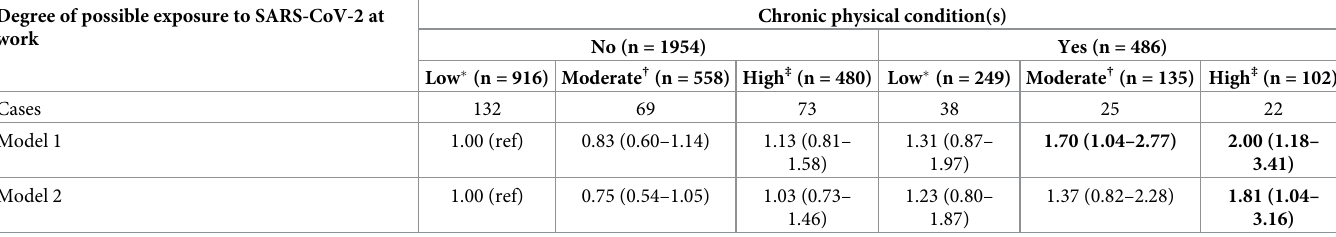
Table 3. Odds ratios and 95% confidence intervals of depressive symptoms according to the combination of the presence of chronic physical condition(s) and degree of possible exposure to SARS-CoV-2 at work. Degree of possible exposure to SARS-CoV-2 at work